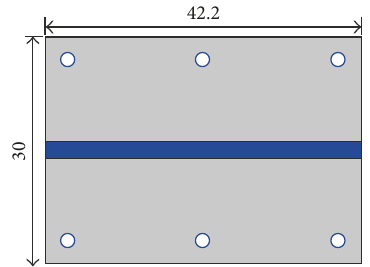
Figure 4: The structure of the line standard.